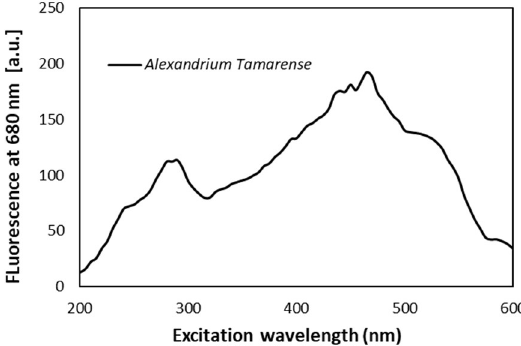
Figure 7. Alexandrium tamarense fluorescence spectrum with several excitation wavelengths. Reprinted/adapted with permission from Ref. [23]. Copyright © 2005 Elsevier B.V. Table 5. Pairs of excitation/emission wavelengths used to distinguish Nannochloropsis gaditana , Isochrysis galbana , Tetraselmis suecica and Alexandrium tamarense and respective measured fluores- cence value. Fluorescence of Nannochloropsis gaditana (a.u.)